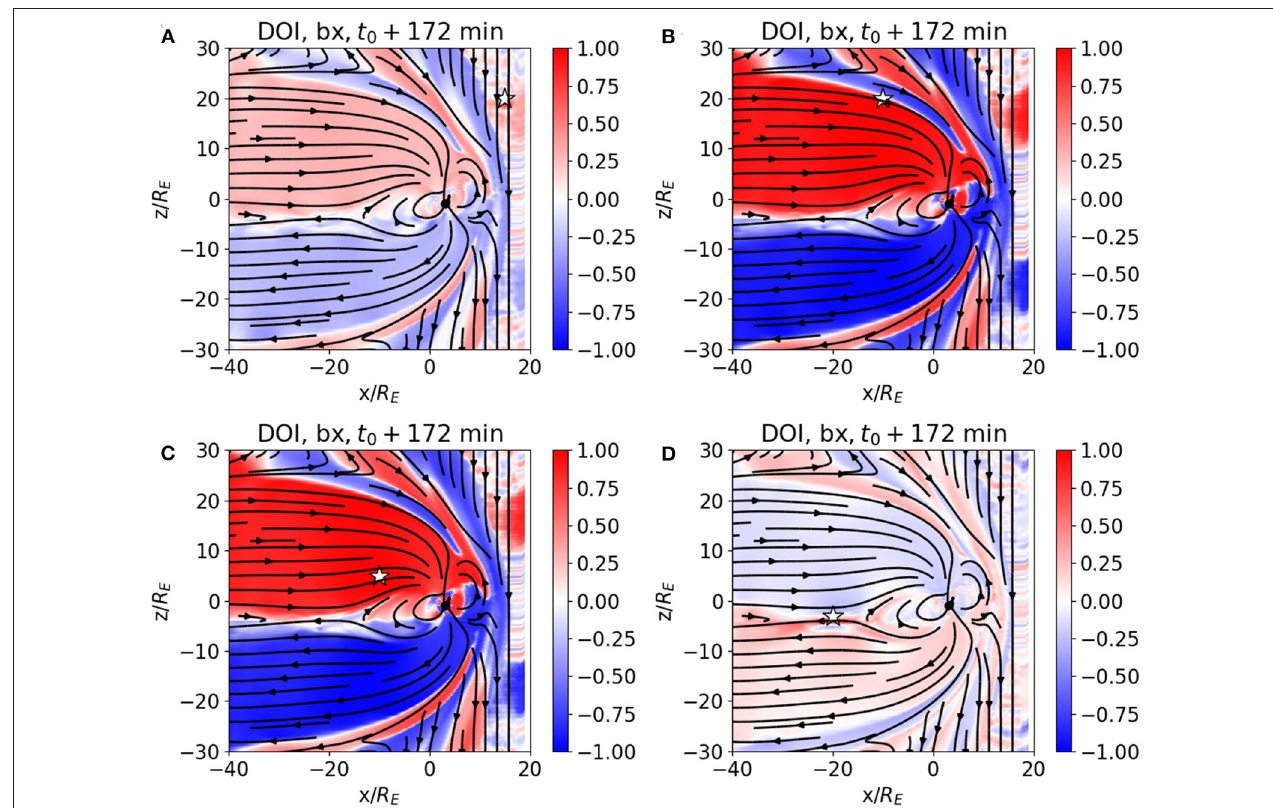
FIGURE 4 | DOI maps for b x , computed from the correlation of an ensemble of OpenGGCM magnetospheric simulations, with observation points in the solar wind (A) , magnetosheath (B) , northern lobe (C) , plasma sheet (D) .